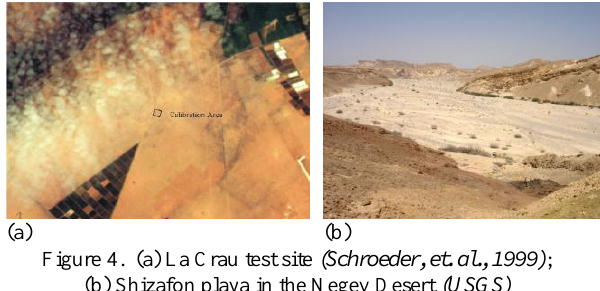
Figure 4. (a) La Crau test site (Schroeder, et. al., 1999) ; (b) Shizafon playa in the Negev Desert (USGS)